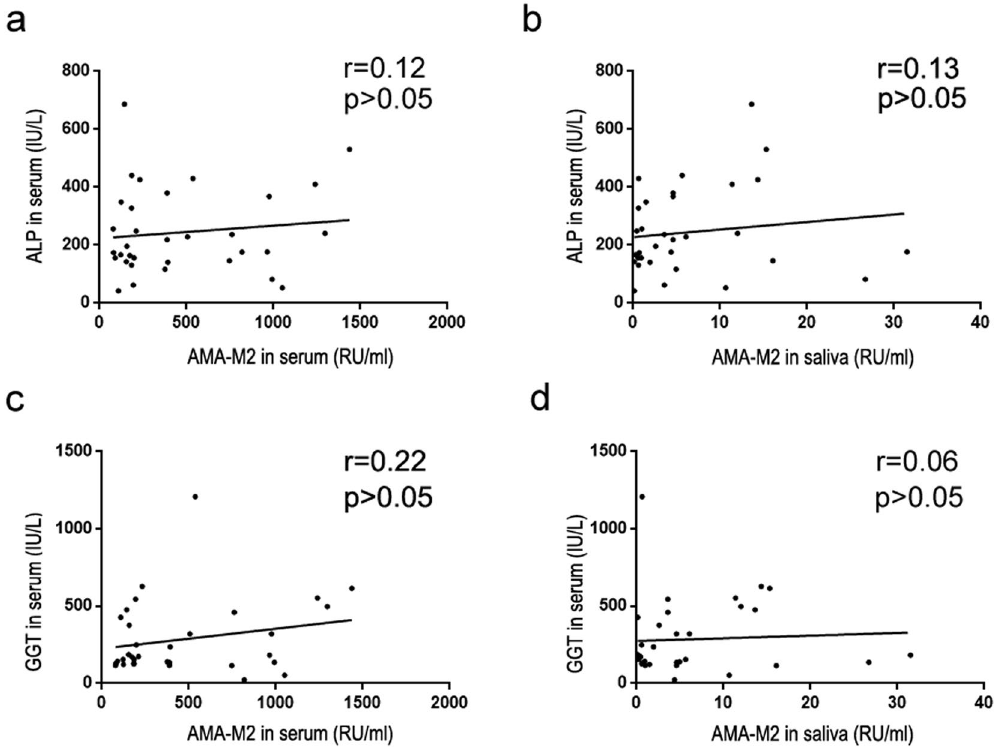
Figure 3. Serum and salivary AMA-M2 levels did not correlate with other hepatic function indicators. ( a ) Correlation between serum AMA-M2 and serum ALP levels in patients with PBC (serum AMA-M2-positive PBC patients, n = 33). ( b ) Correlation between salivary AMA-M2 and serum ALP levels in patients with PBC (serum AMA-M2-positive PBC patients, n = 33). ( c ) Correlation between serum AMA-M2 and serum GGT levels in patients with PBC (serum AMA-M2-positive PBC patients, n = 33). ( d ) Correlation between salivary AMA-M2 and serum GGT levels in patients with PBC (serum AMA-M2-positive PBC patients, n =